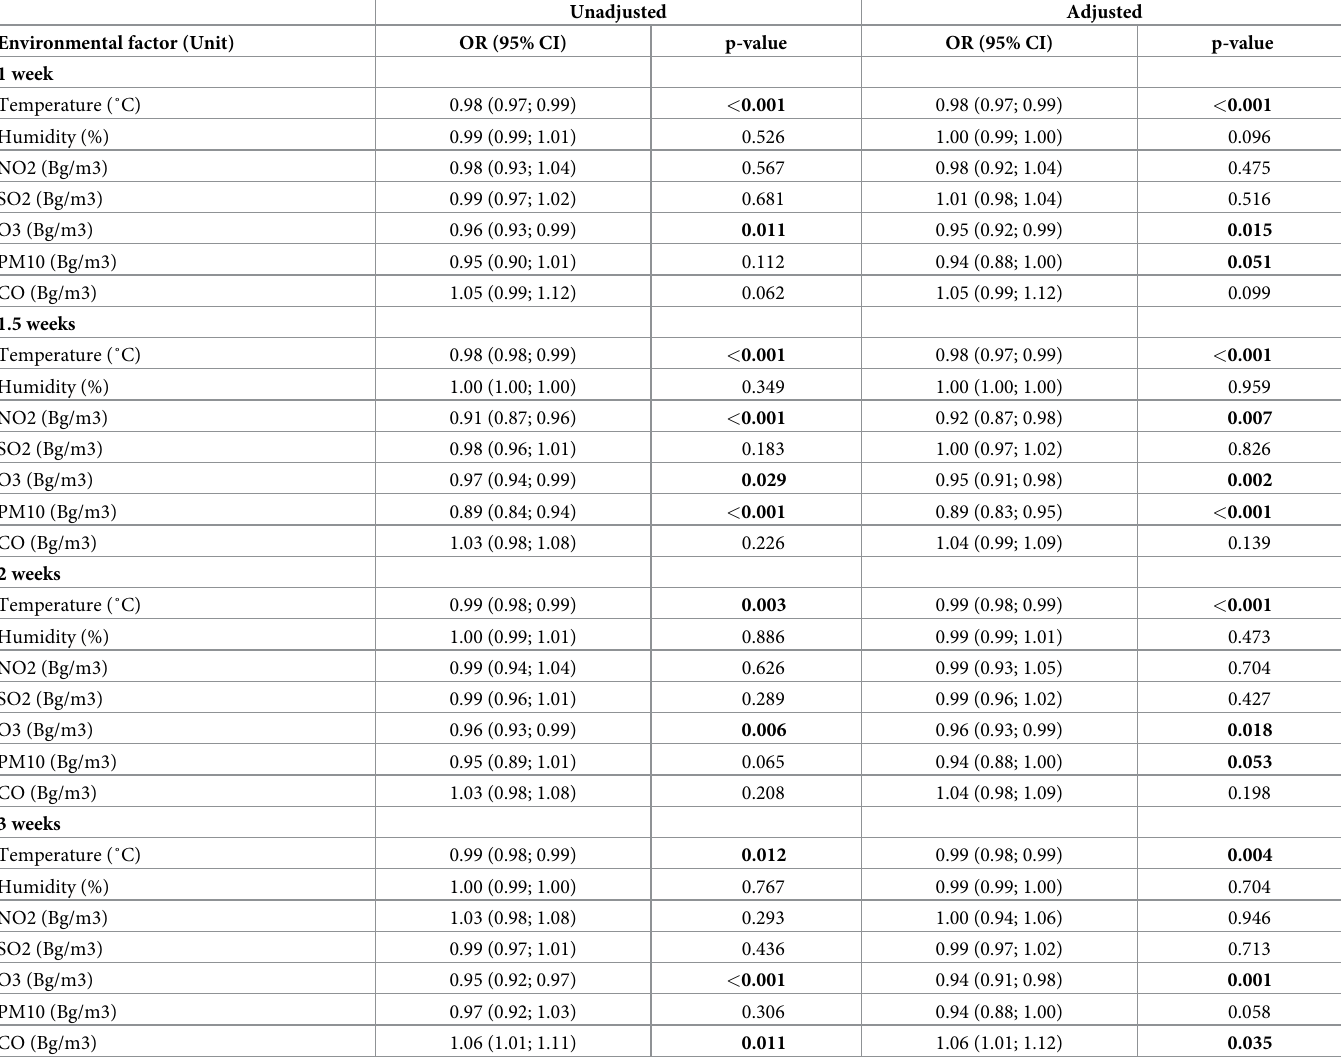
Table 3. Bivarite and multivariable models results for the associations between environmental factors and in hospital mortality after COPD exacerbation hospital admissions for study time periods (1, 1.5, 2 and 3 weeks before hospitalization).